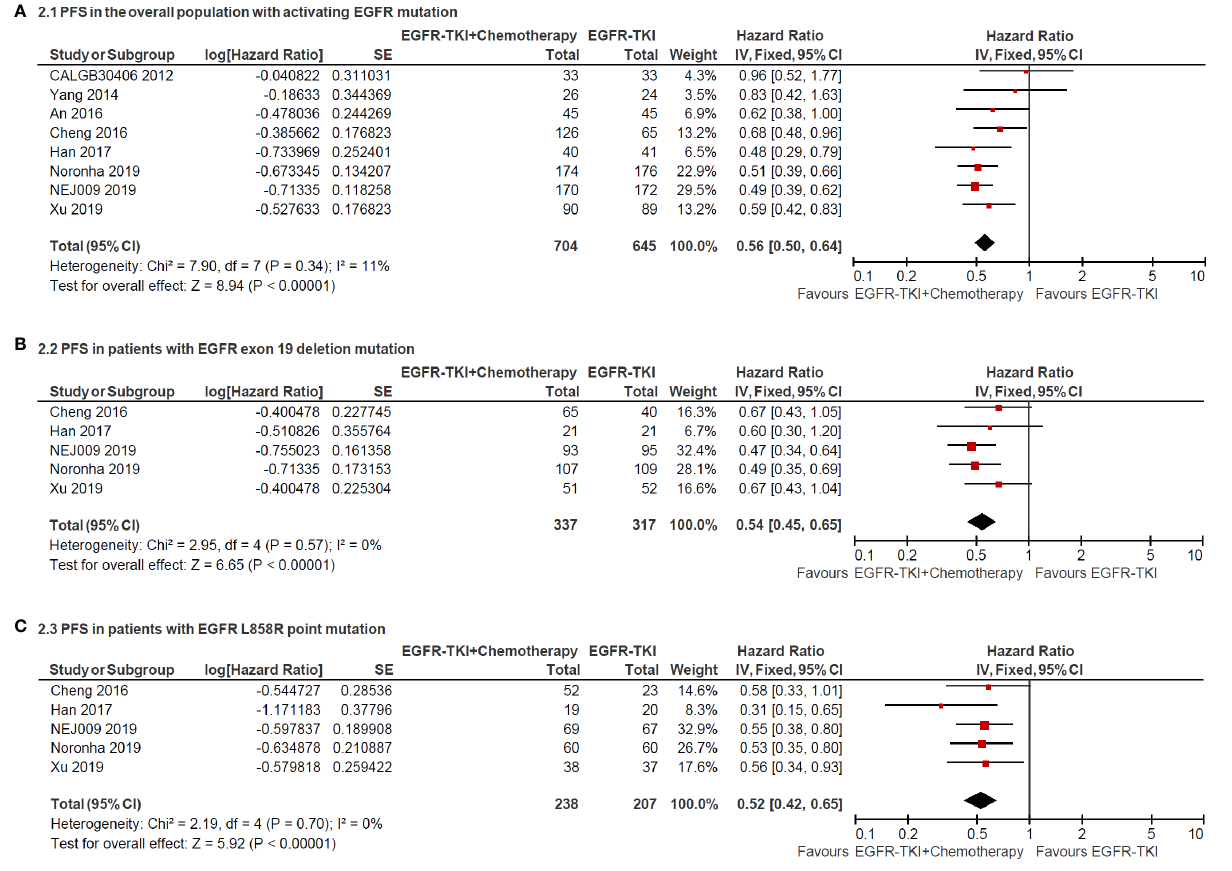
FIGURE 2 | Forest plot of hazard ratio of progress-free survival in overall patients with all sites of positive activating EGFR mutation (A) ; in patients with positive exon 19 deletion mutation (B) and positive L858R point mutation (C)